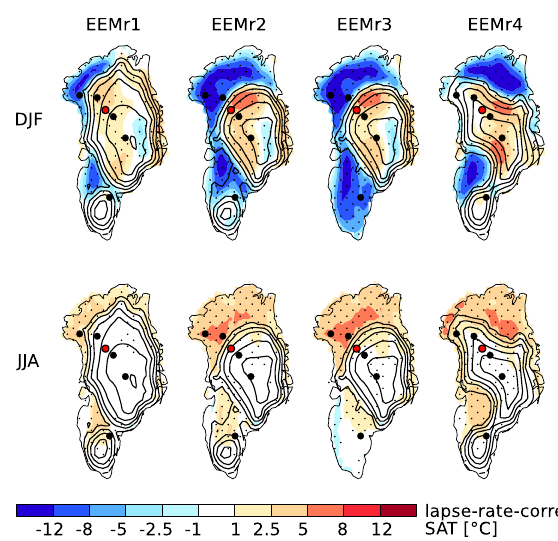
Figure 5. Lapse-rate-corrected SAT anomalies ( ◦ C) from EEMpd in the perturbed Eemian simulations over Greenland for DJF and JJA. Black isolines denote the ice sheet surface elevation (500m contour interval) in the corresponding simulation. Stippling denotes significant temperature anomalies at the 5% level based on t test